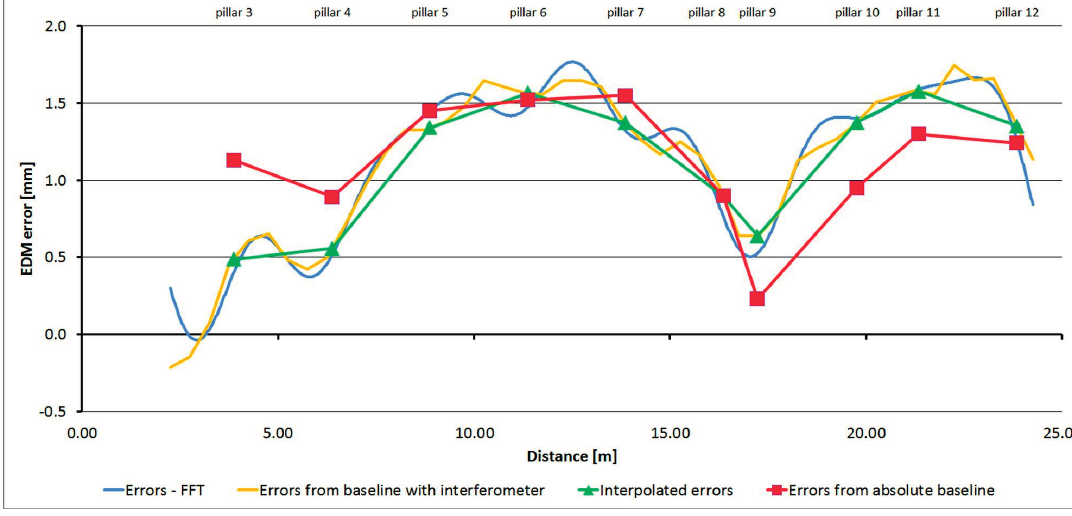
Figure 33. The resulting graph of the combination of absolute and relative errors and the correcting function by FFT–Trimble